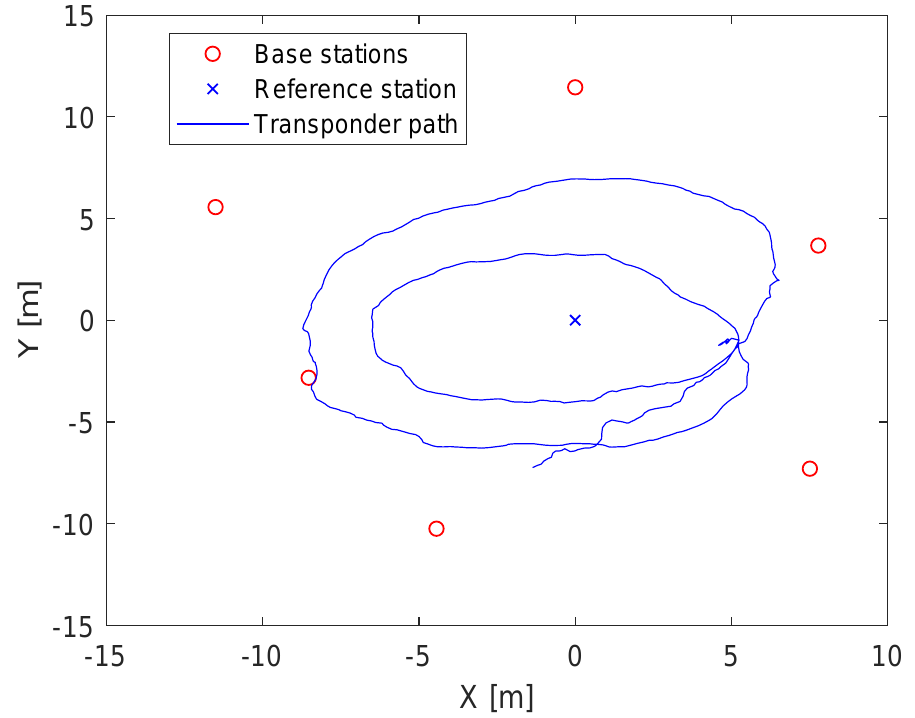
Figure 5. Constellation of the LPM system. Red circles are the base stations, the blue cross the reference station, and the blue line the tag